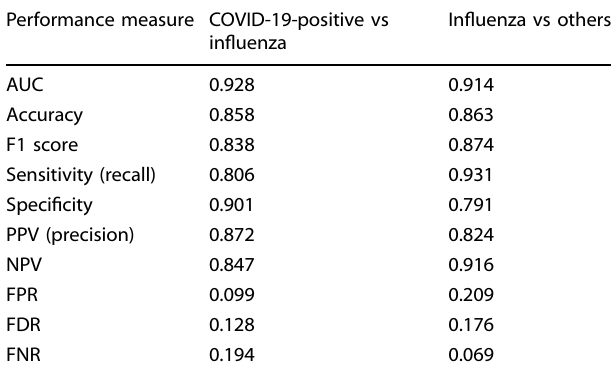
Table 4. Performance of in fl uenza versus COVID-19-positive and in fl uenza versus others (COVID-19-positive/-negative) classi fi cation models on the external validation